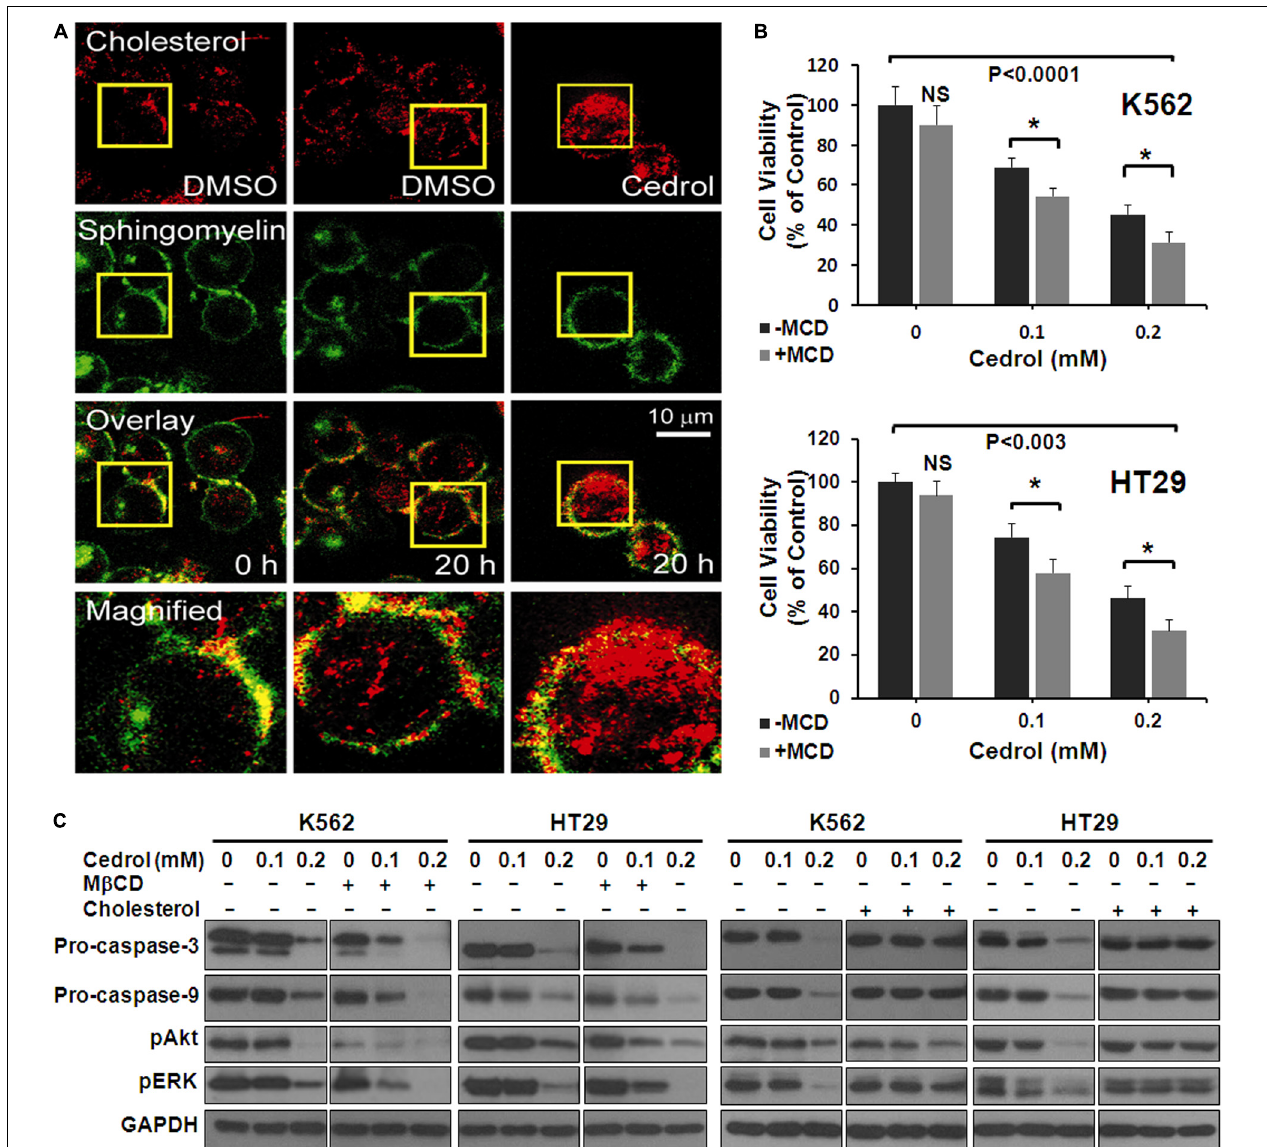
FIGURE 4 | Cedrol redistributed cholesterol from membrane lipid raft. (A) K562 cells were treated with VH or cedrol (200 µ M) for 20 h. Cells were treated with Bodipy-labeled sphingomyelin and cholesterol, then visualized under a confocal microscope. VH-treated cells were visualized at 0 h to imagine the basal membrane organization. Yellow boxes represent the area magnified. (B) K562 and HT29 cells were treated with 2.5 mg/ml methyl- β -cyclodextrin (M β CD) for 2 h in serum-free medium. Cells were then treated with either VH or cedrol in serum-free media for 48 h, and cell viability was assayed. (C) K562 and HT29 cells were treated with or without M β CD (2.5 mg/ml), cholesterol (10 µ g/ml), and cedrol for 18 h. Protein isolation and Western blotting were